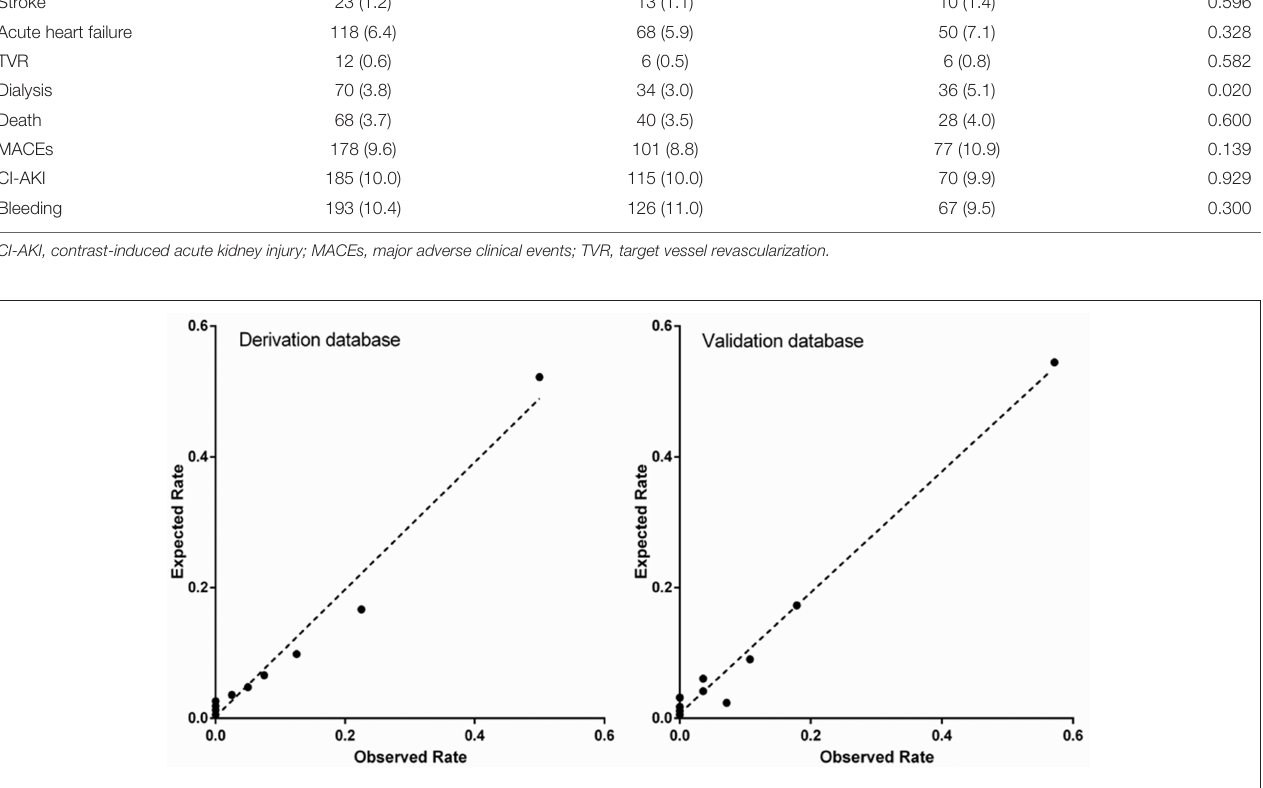
FIGURE 1 | Calibration of shock index-C for in-hospital mortality in the derivation and validation